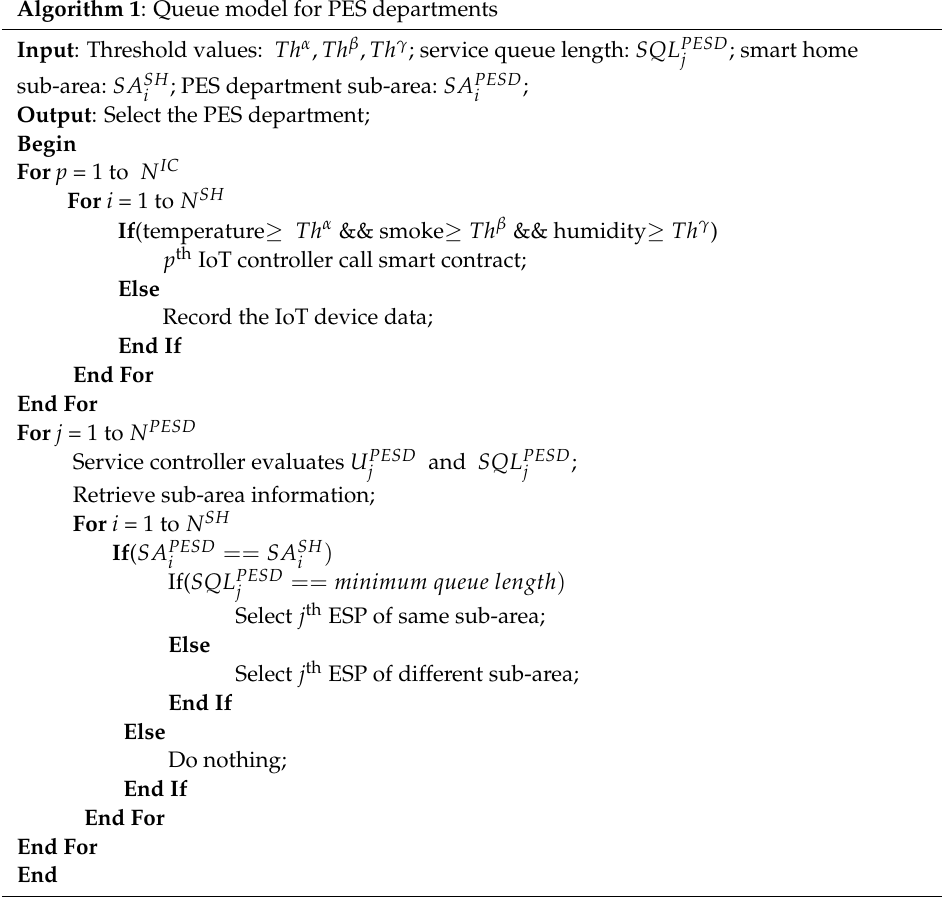
Algorithm 1 : Queue model for PES